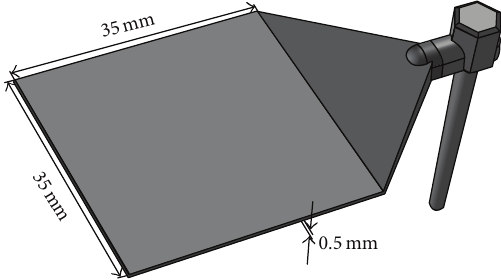
Figure 1: Geometry of the used plate specimen.